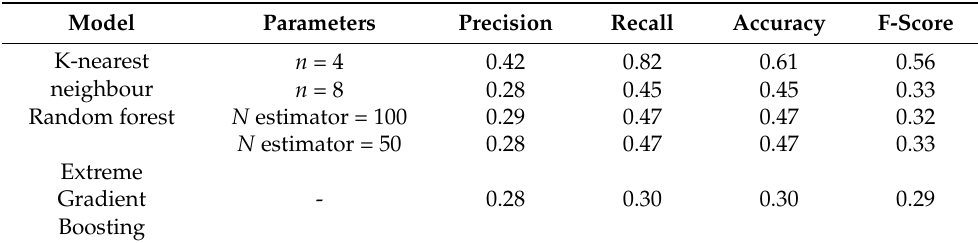
Table 2. VGG16-based transfer learning feature